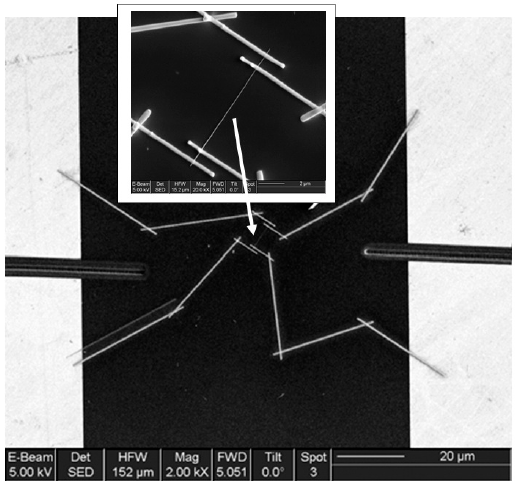
Figure 14. General view of the final device based on the SnO 2 individual nanowire (dimensions: L = 11 µ m (length) and D = 55 ± 5 nm (diameter)) with Au / Ti / Ni microelectrodes. The position of the contacted NW is indicated by the arrow. Reproduced with permission from Hernandez-Ramirez et al. [159]. Copyright 2007: Elsevier.